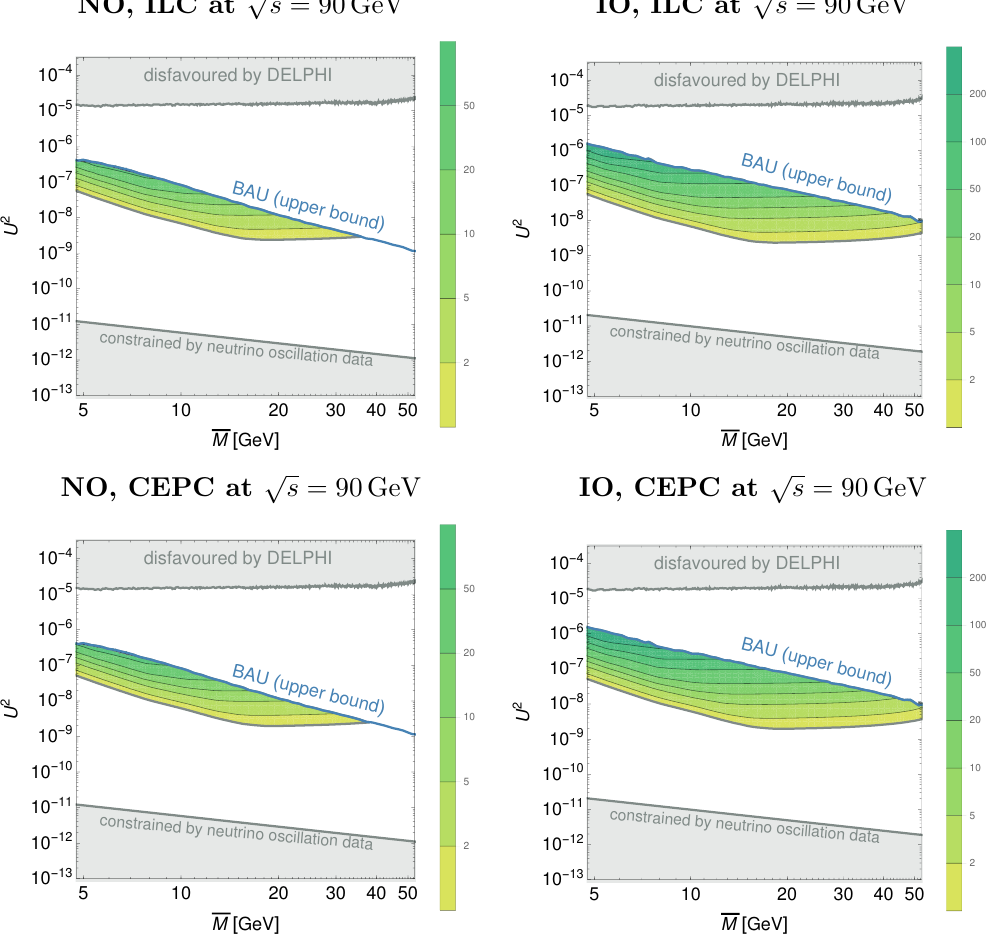
p s = 90 GeV (top line) and at the